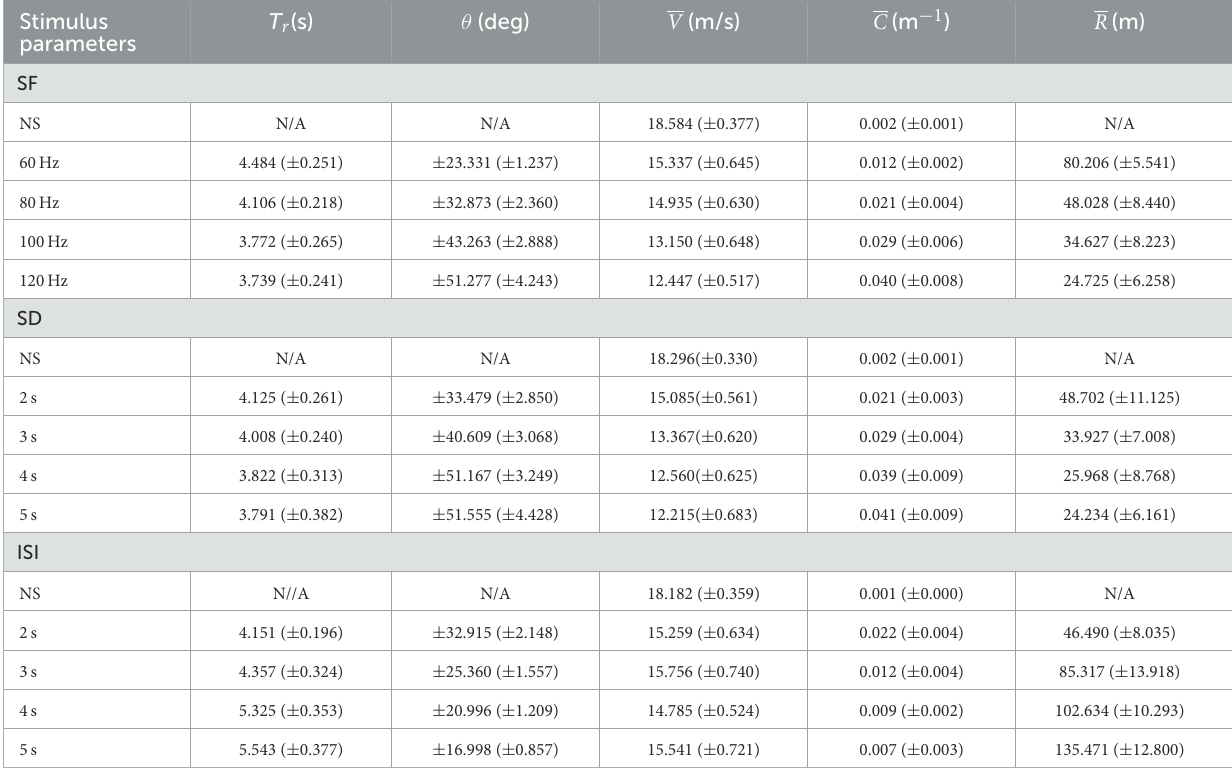
TABLE 2 Results of the robo-pigeons turning flight controlled with the varied parameters of SF, SD and ISI. Stimulus